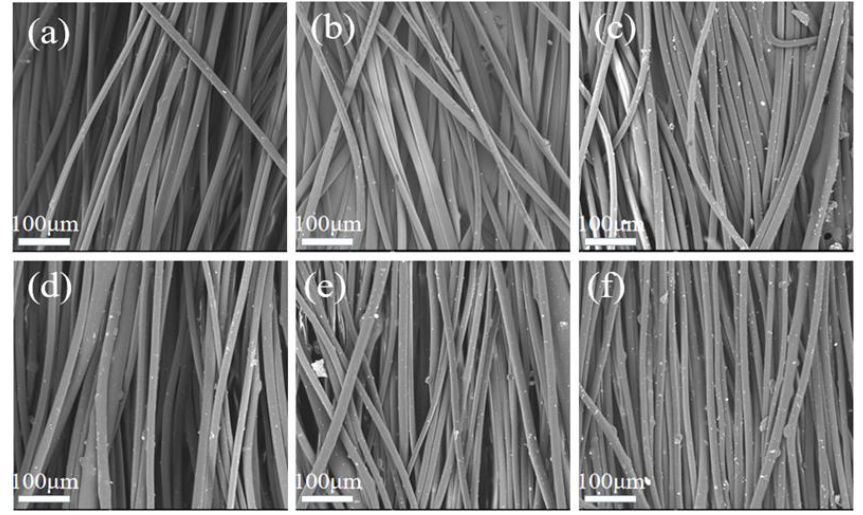
Figure 2. The SEM images of e-spun PP fibers containing ZnO: ( a ) 0 wt.%; ( b ) 1 wt.%; ( c ) 2 wt.%; ( d ) 3 wt.%; ( e ) 4 wt.%; ( f ) 5 wt.%.